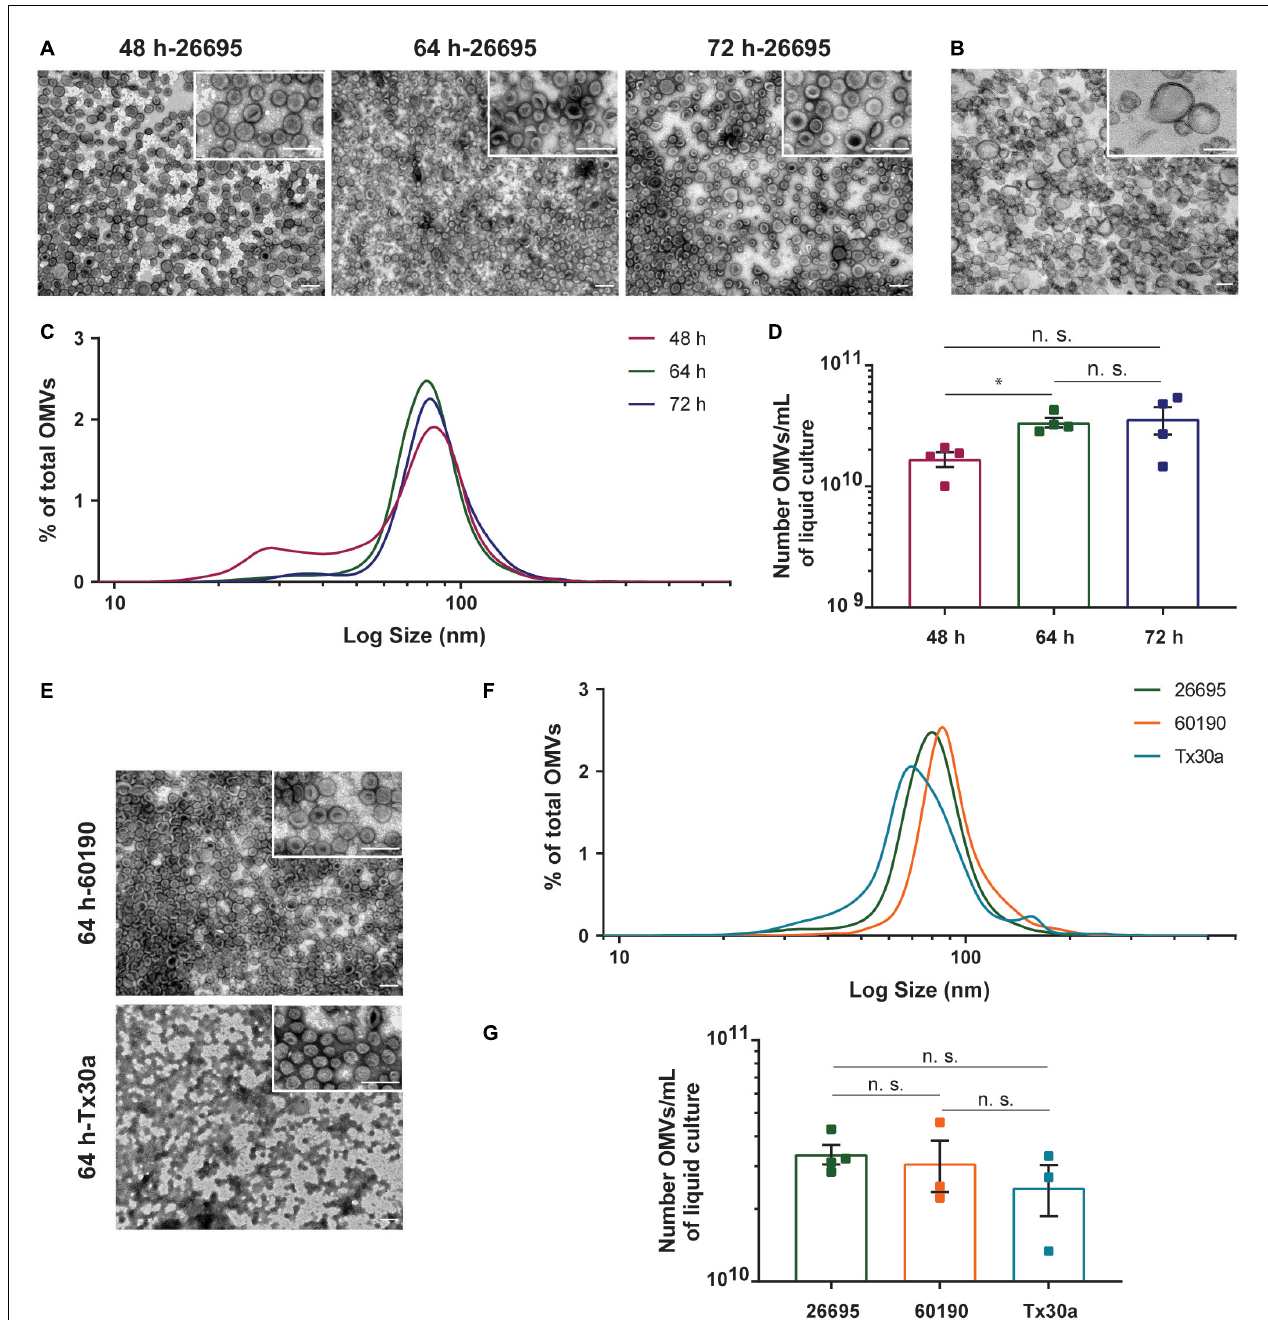
FIGURE 3 | Morphological characterization, size distribution, and yield of OMVs secreted by Helicobacter pylori grown in F12-cholesterol medium. (A) Negative staining of OMVs isolated from H. pylori 26695 F12-cholesterol liquid cultures at 48, 64, and 72 h of growth, and (B) ultrastructure section of OMVs from 64 h H. pylori cultures. Scale bars: 200 nm; 50,000 × , 100,000 × [insets in panel (A) ] and 200,000 × [inset in panel (B) ] original magnifications. (C) Size distribution, represented as percentage of the total number of isolated OMVs; data are shown as mean ± SEM of four biological replicates and statistical significance was evaluated using the one-way ANOVA with post hoc Tukey’s test; n.s. – not significant. (D) Number of recovered OMVs per mL of bacterial culture, determined using Nanoparticle Tracking Analysis (NTA) at 48, 64, and 72 h periods of bacterial growth; data are shown as mean ± SEM of four biological replicates and statistical significance was evaluated using the one-way ANOVA with post hoc Tukey’s test; * p ≤ 0.05, n.s. – not significant. (E) Representative negative stain TEM micrographs of H. pylori 60190 and Tx30a-OMVs generated from 64 h F12-cholesterol bacterial cultures. Scale bars: 200 nm; 50,000 × and 100,000 × (insets) original magnification. (F) Size distribution, represented as percentage of the total number of isolated OMVs at 64 h of liquid culture, and (G) number of recovered OMVs per mL of bacterial culture determined by NTA; data are shown as mean ± SEM of 4 (for 26695) or 3 (for 60190 and Tx30a ) biological replicates and statistical significance was evaluated using the Brown-Forsythe and Welch ANOVA with post hoc Dunnett’s test; n.s. – not significant.